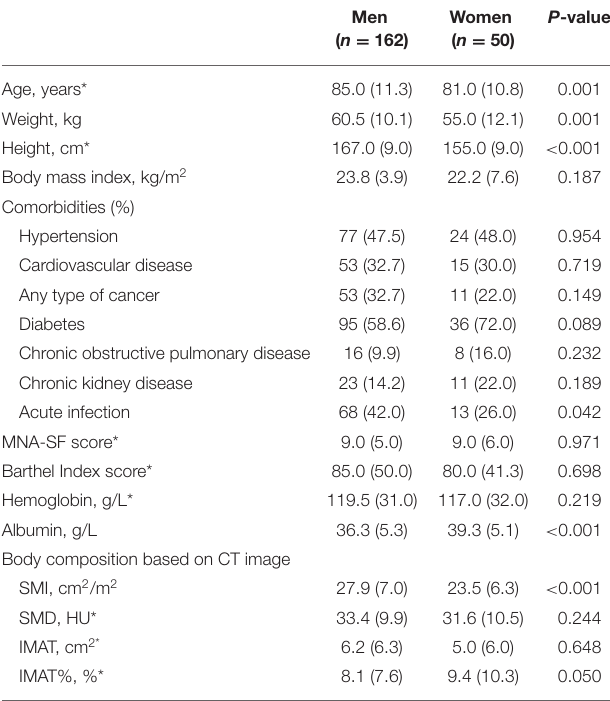
TABLE 1 | Characteristics of the study population ( n =